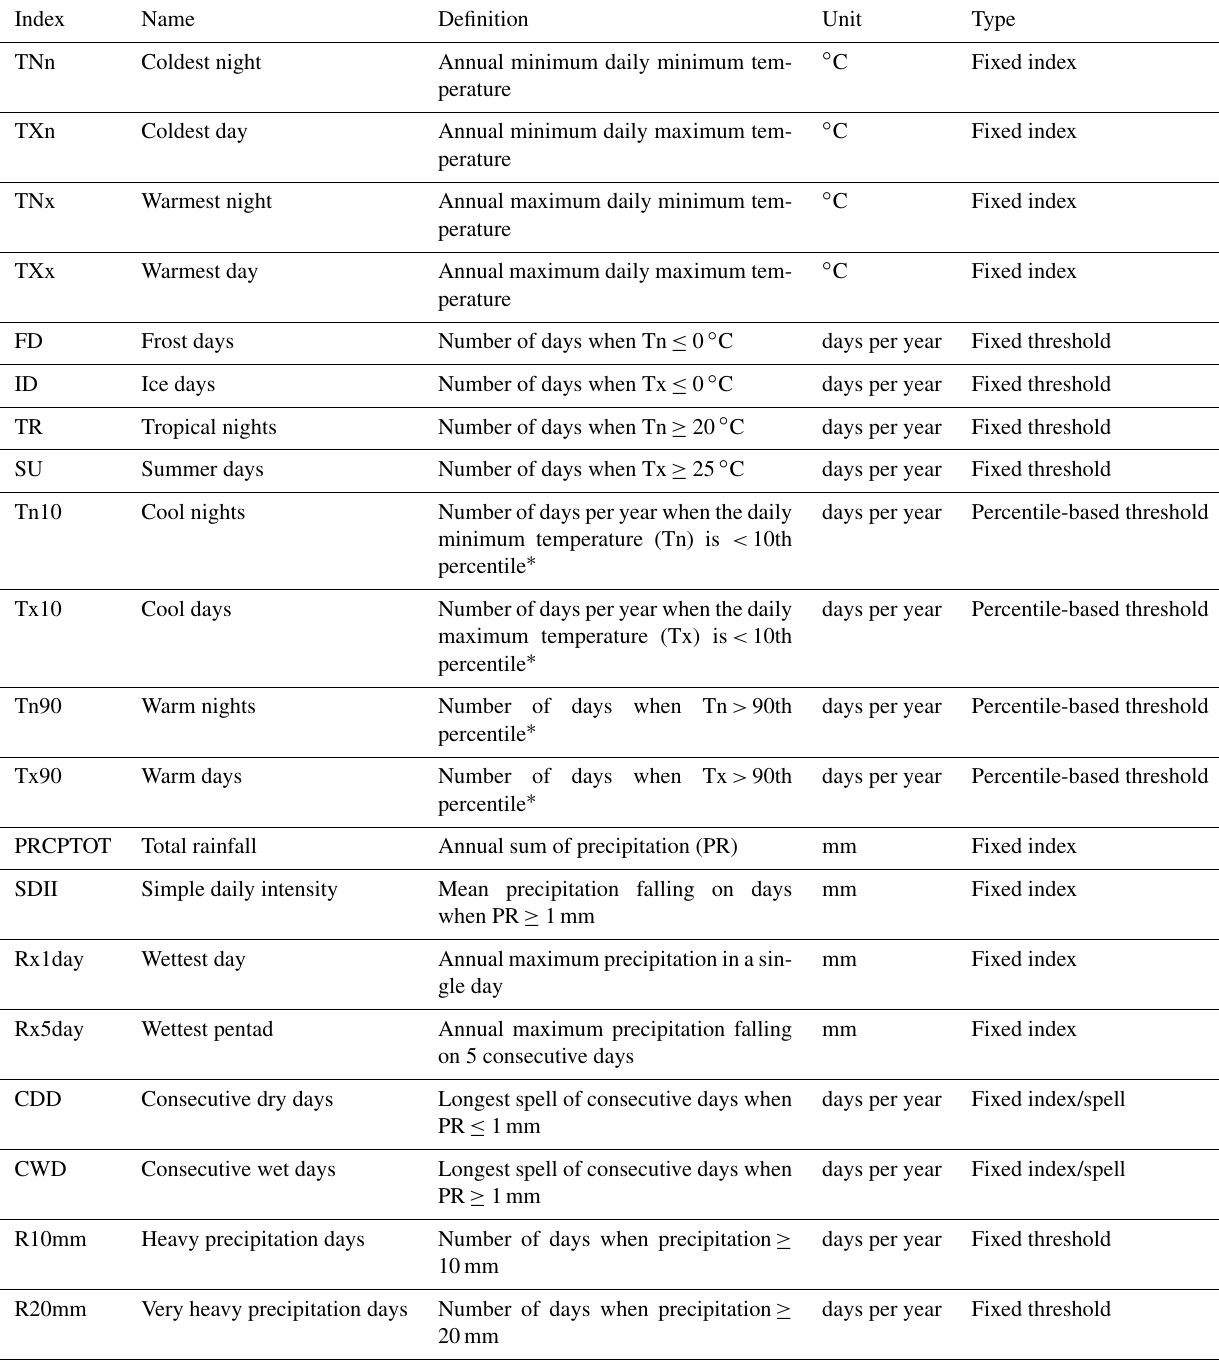
Table 2. Selection of extreme indices developed by ETCCDI (Klein Tank et al., 2009). Percentiles marked with ∗ were estimated from a base period of 2010–2030 and are only included in the Supplement; values are calculated as a climatological average for the end of the century